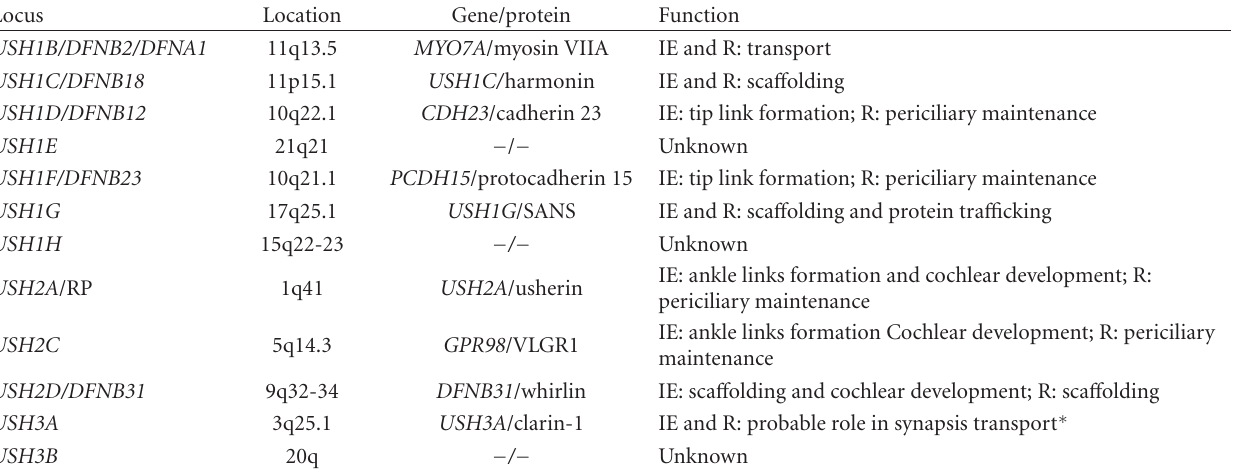
Table 2: Genetic classification of Usher